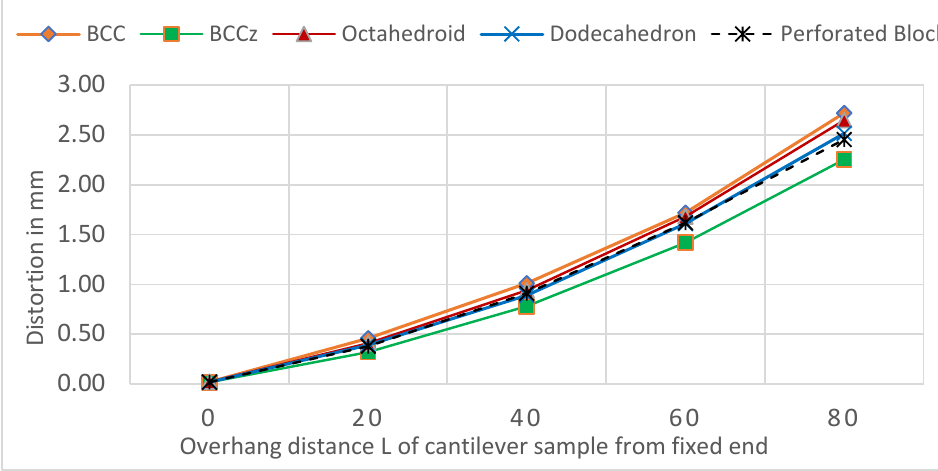
Figure 11. Cantilever part distortion comparison after support separation.